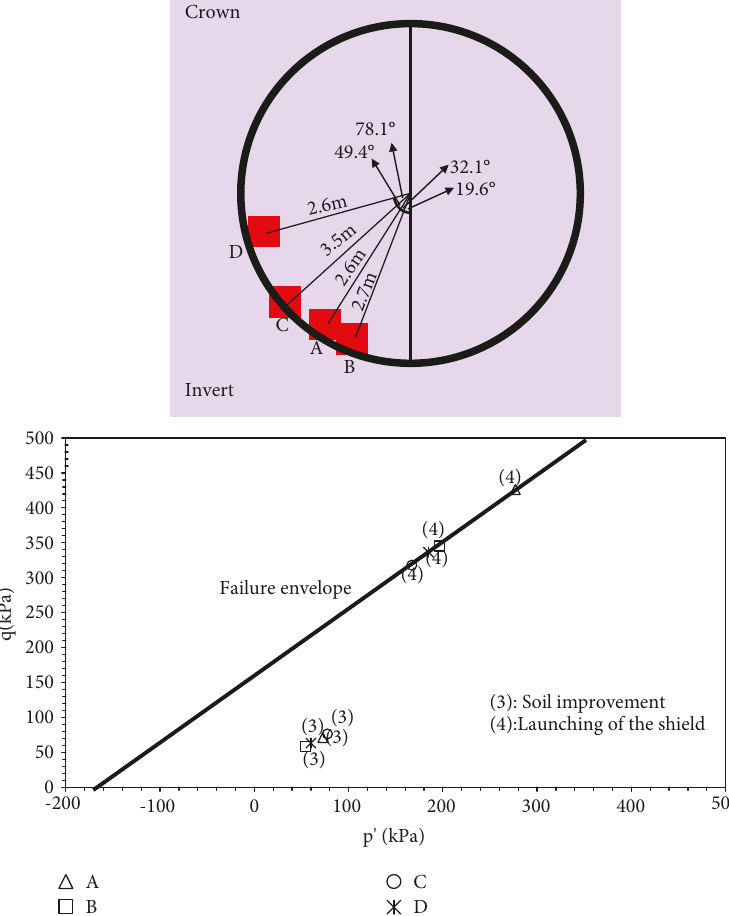
Figure 10: E ff ective stress path and failure envelope for failure caused by launching of a shield for soils immediately behind the